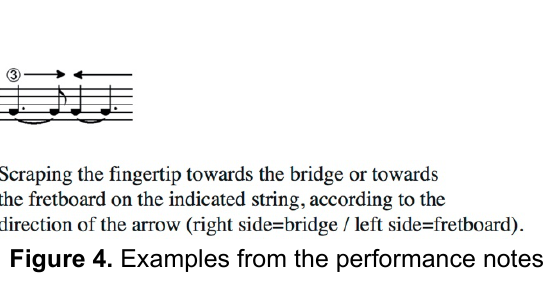
Prescriptive action-notation in particular,